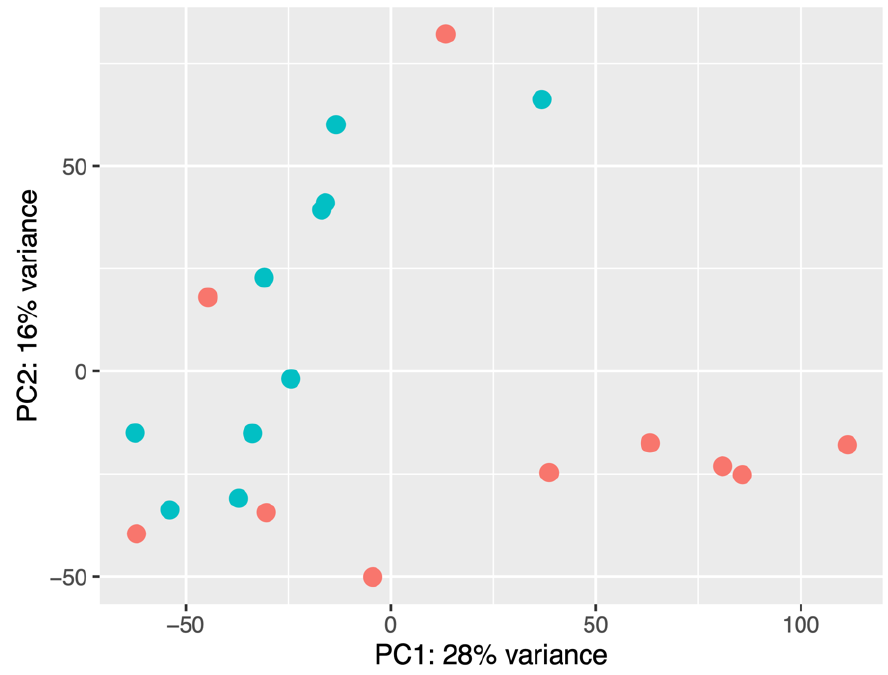
Figure 2. PCA of normocholesterolemic ( n = 10) and hypercholesterolemic ( n = 10) participants. Red dots: hypercholesterolemic. Blue dots: normocholesterolemic.